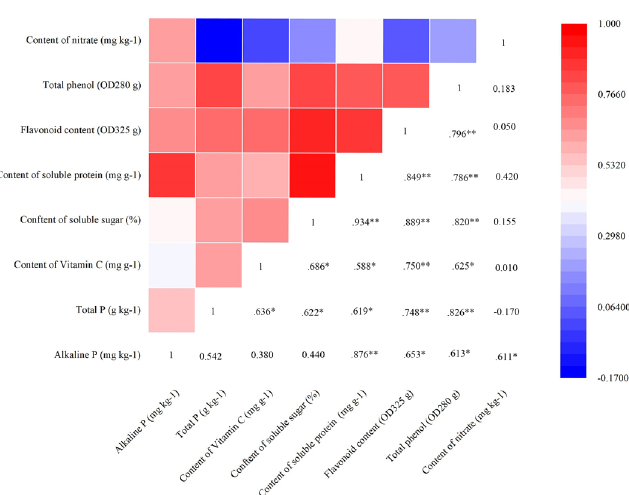
Figure 9. Heat map of Pearson’s correlation coefficient matrix between the wintering Chinese chives quality variables and available P and total P. The values in the figure are Pearson’s correlation coefficient. * and ** denote correlation coefficients that are significant at p < 0.05 and 0.01 level, respectively. Heat map of Pearson’s correlation coefficient matrix was produced by OriginPro 2019b